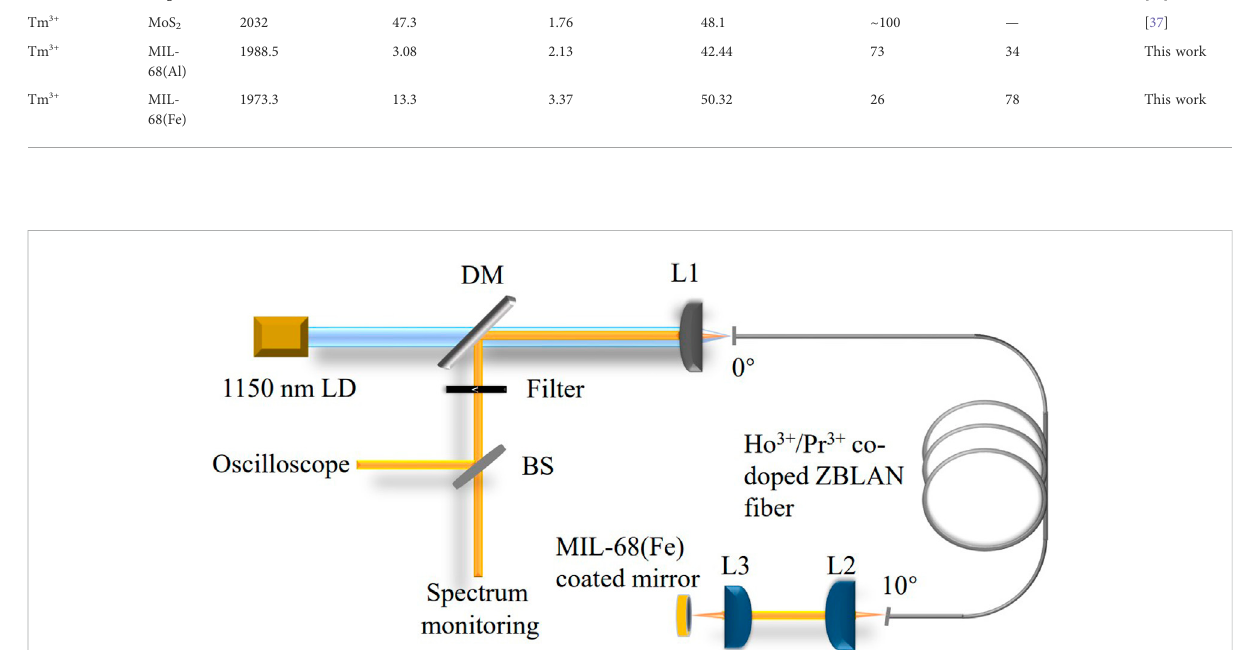
FIGURE 8 Experimental setup of the passively Q-switched Ho 3+ /Pr 3+ -doped ZBLAN fi ber laser based on the MOFs